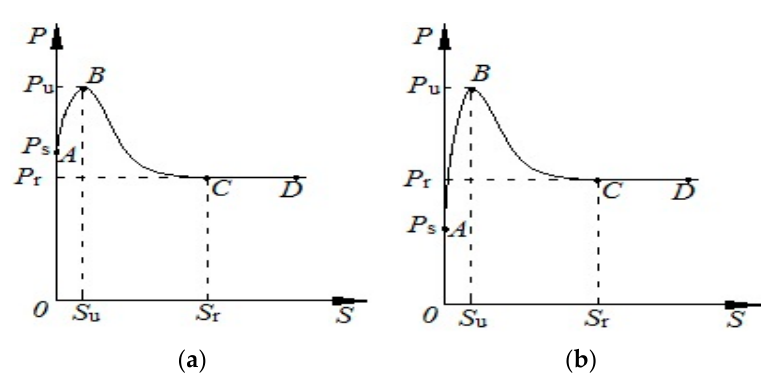
Figure 6. P–S curve models of the loading end: ( a ) Type (I); ( b ) Type (II).